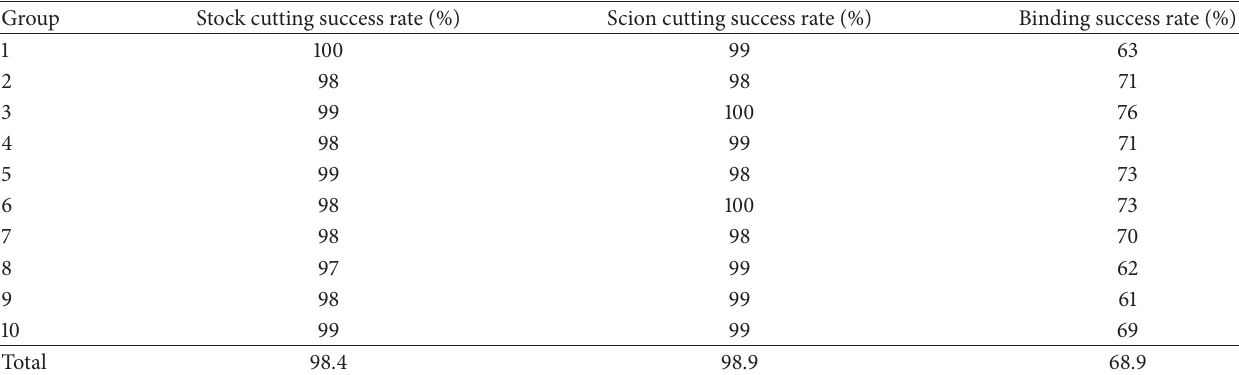
Table 1: Results of stock cutting, scion cutting, and binding